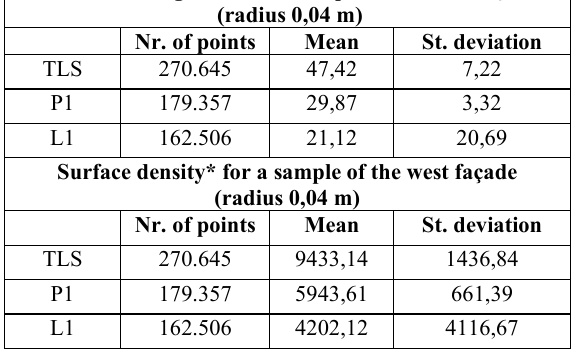
Number of neighbors for a sample of the west façade